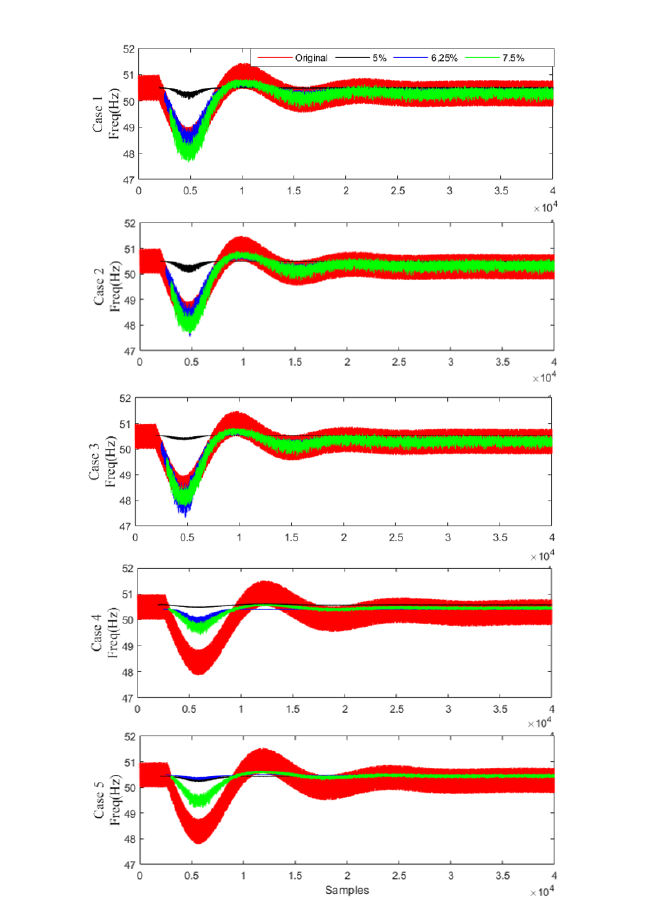
Figure 12. Results for the LSTM models in all simulation cases with added noise.